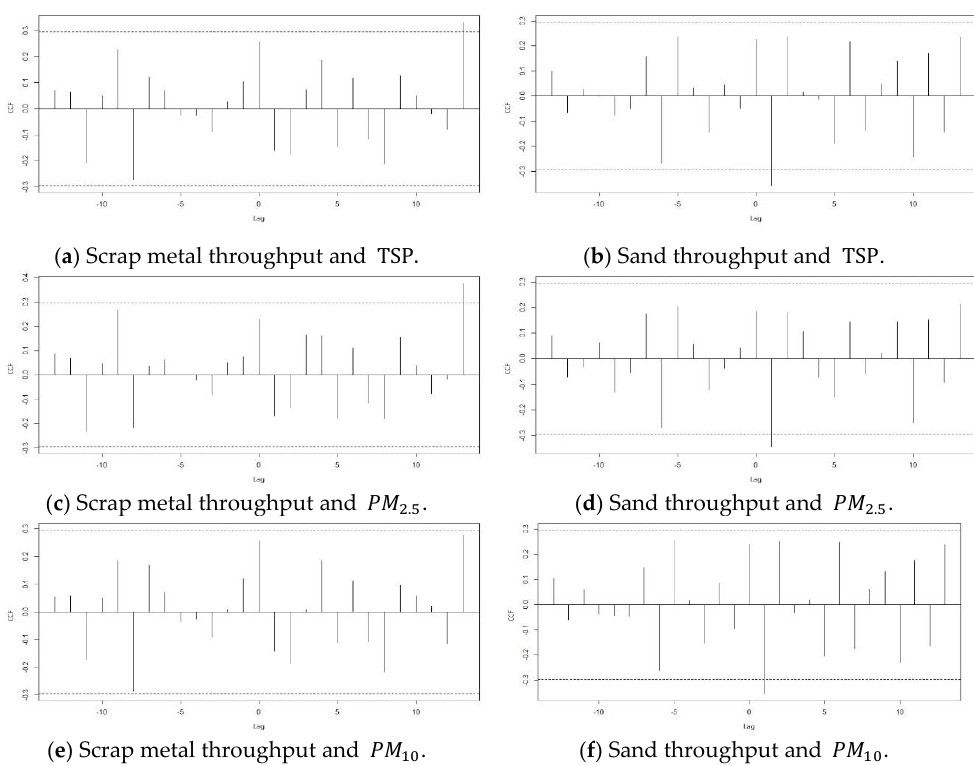
Figure 8. Cross-correlations after pre-whitening between the main cargo and fine dust concentrations.